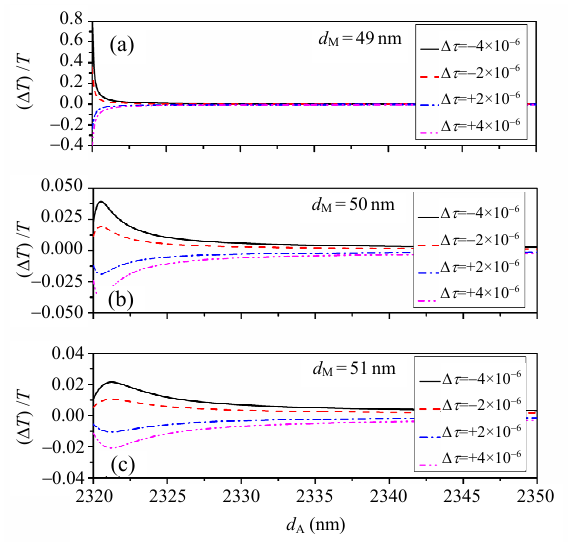
Fig. 10 Relative difference of the transmittances versus d A for different n A : (a) d M = 49 nm, (b) d M = 50 nm, and (c) d M = 51 nm.